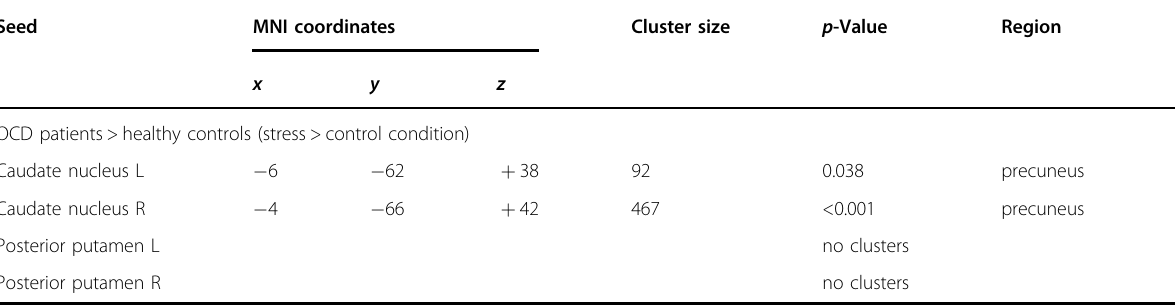
Table 2 Signi fi cant clusters from the seed-to-voxel group × condition interaction analysis. Seed MNI coordinates Cluster size x y z OCD patients > healthy controls (stress > control condition) Caudate nucleus L Posterior putamen L Posterior putamen